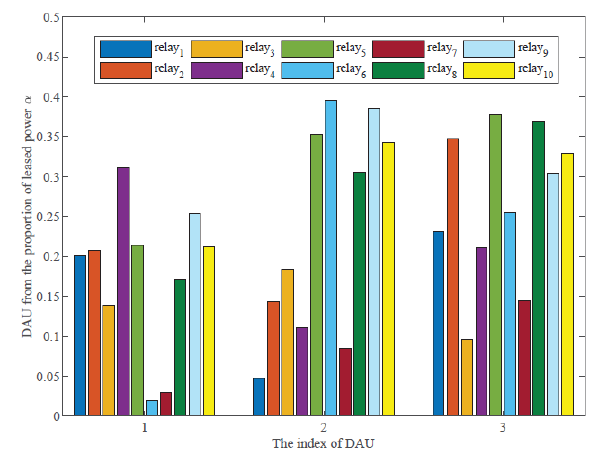
Figure 3. The allocation of relay power to each DAU.